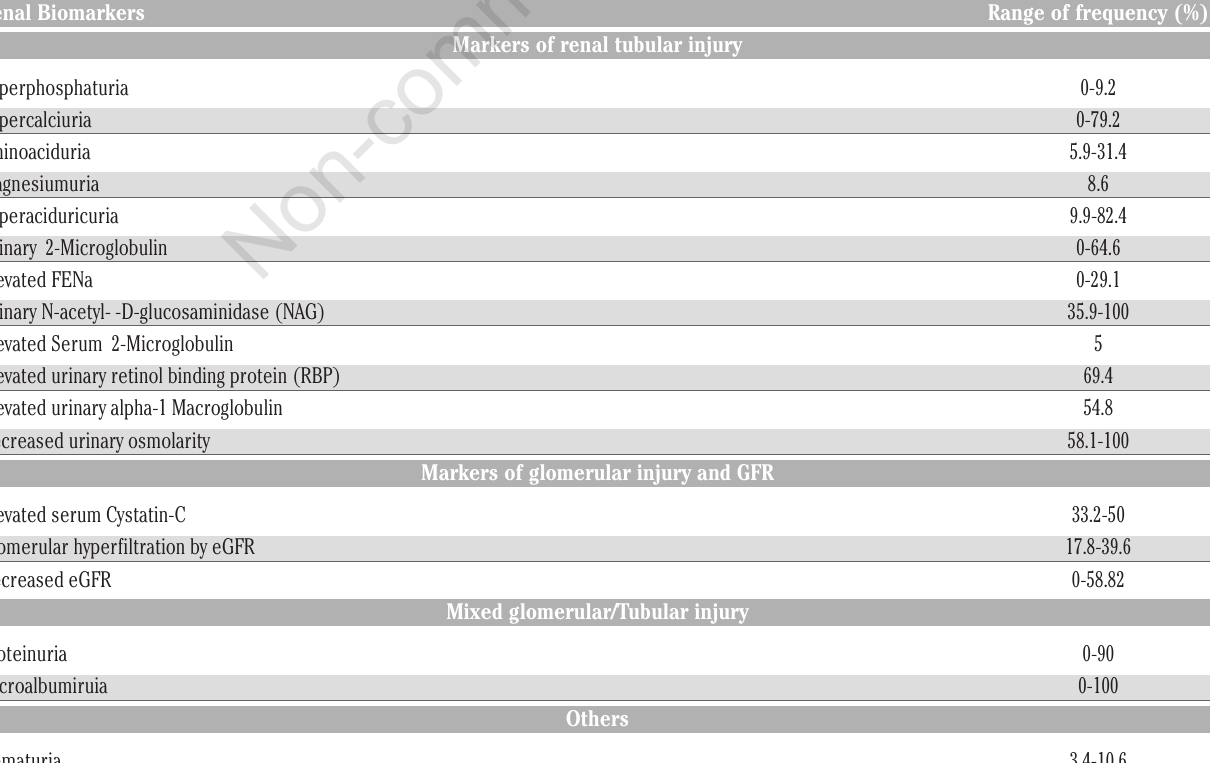
Table 1. Frequency of positive renal biomarkers throughout studies in TDT, organized by renal injury types. Renal